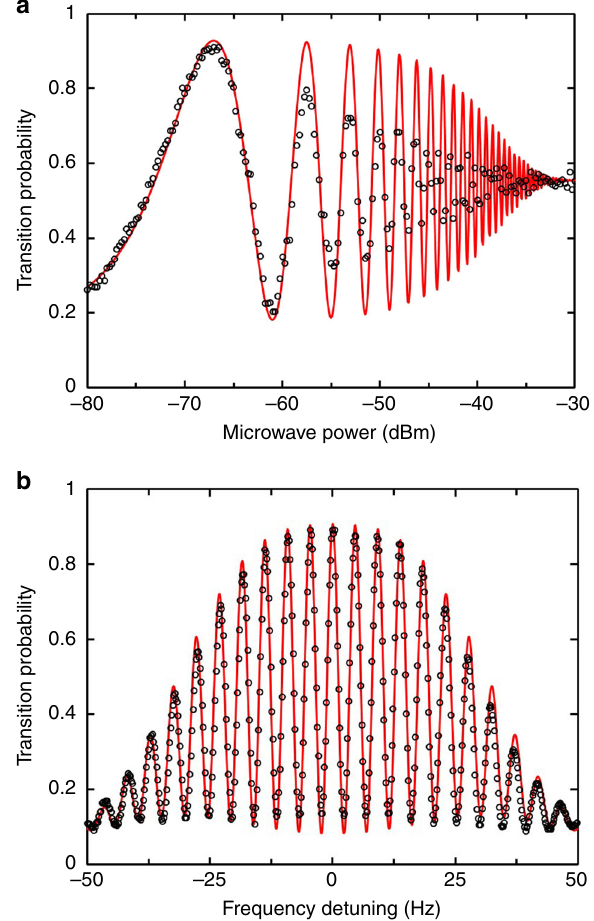
Fig. 4 Atomic population oscillations after microwave interrogation. a Population oscillations vs. microwave power and b Ramsey fringes in microgravity with a launch velocity of 1.1 m s − 1 , used in closed-loop operation. The black circles represent measured data and the red lines